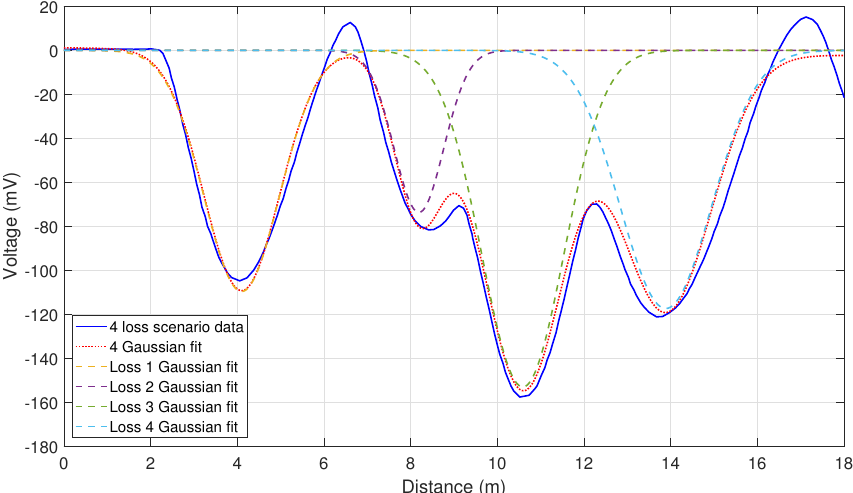
Figure 10. The Cherenkov signal for a four loss location scenario from the right 400 µ m core fibre, with a four Gaussian fit and the individual loss Gaussian